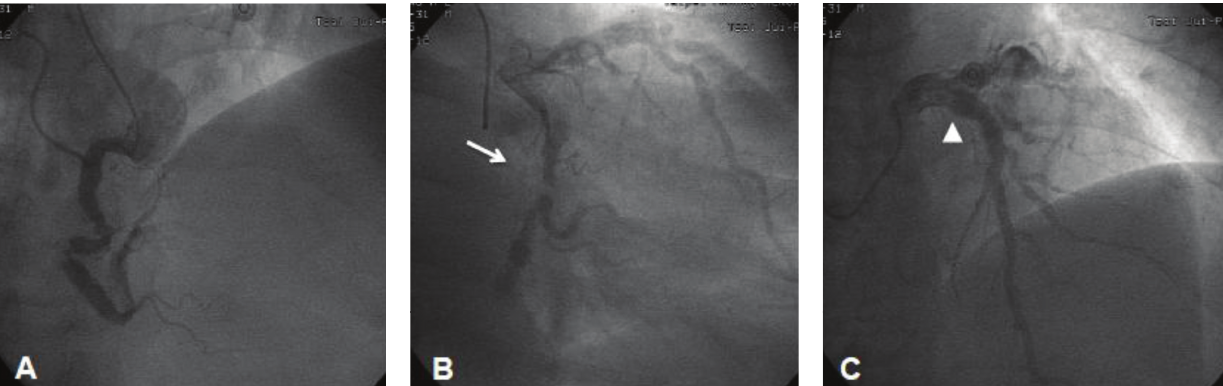
Figure 1: Coronary angiography revealing ectasia in the (A) right coronary artery, (B) left circumflex artery (arrow), and (C) left descending artery (arrow head).